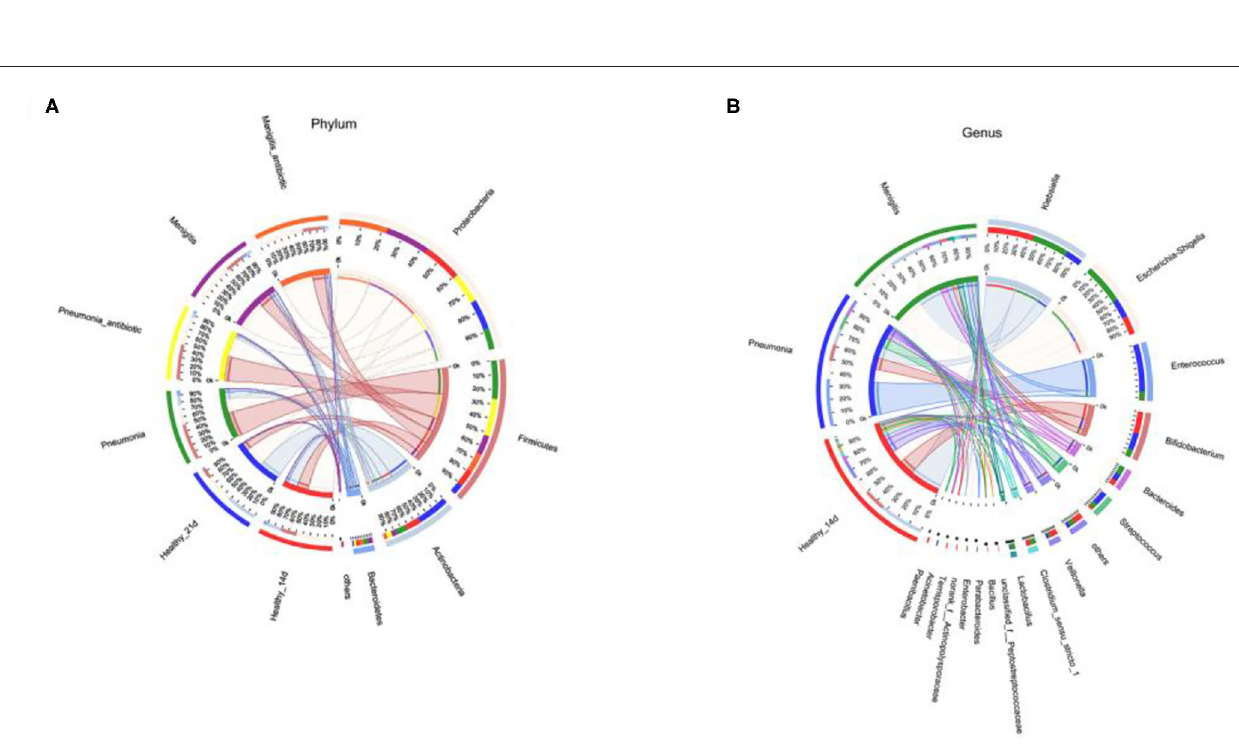
Frontiers in Pediatrics |